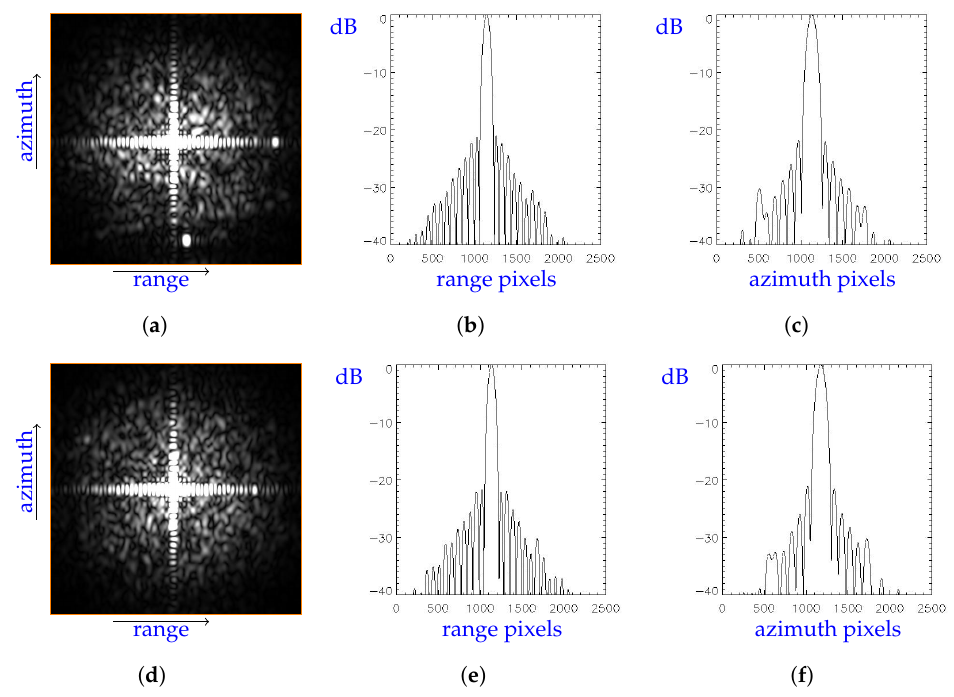
Figure 11. Corner reflectors within the burst 8 of sub-swath 1: ( a ) image, ( b ) IRF central cross section along range direction expressed in dB, ( c ) IRF central cross section along azimuth direction expressed in dB, for the corner reflector D39. ( d ) image, ( e ) IRF central cross section along range direction expressed in dB, ( f ) IRF central cross section along azimuth direction expressed in dB, for the corner reflector